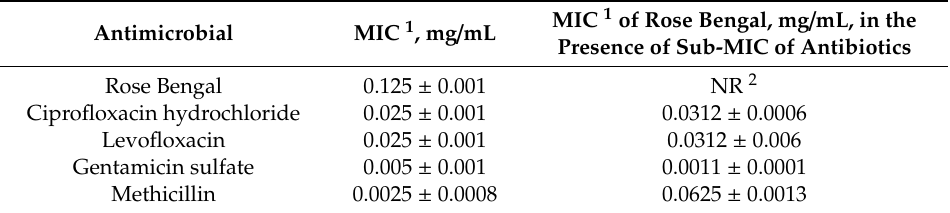
Table 1. MIC values of Rose Bengal and antibiotics for S. aureus in the dark. MIC 1 of Rose Bengal, mg / mL, in the Antimicrobial MIC 1 , mg / mL Presence of Sub-MIC of Antibiotics Rose Bengal 0.125 ±